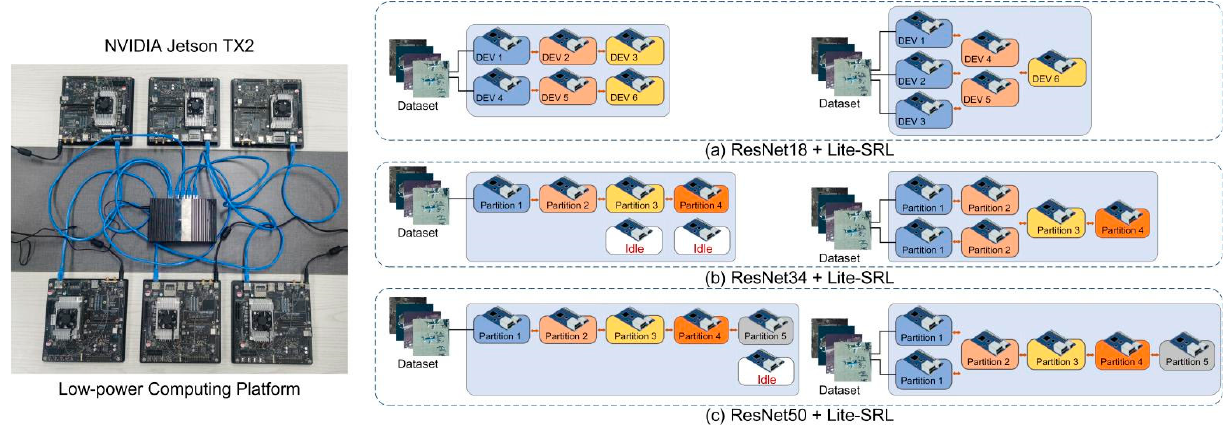
Figure 15. The left side is the illustration of baseline and the right side is the illustration of dynamic chain system. ( a ) Lite-SRL with ResNet-18 as encoder; three nodes are required to complete the training of a mini-batch, baseline uses six nodes to form two chains, and dynamic can form three chains. ( b ) Lite-SRL with ResNet-34 as encoder; four nodes are required to complete the training of a mini-batch. Baseline forms one chain with two nodes idle, while the dynamic chain system can schedule all nodes for training. ( c ) Lite-SRL with ResNet-50 as encoder, five nodes are required to complete the training of a mini-batch. Baseline forms one chain with 1 node idle, while the dynamic chain system can schedule all nodes for training.